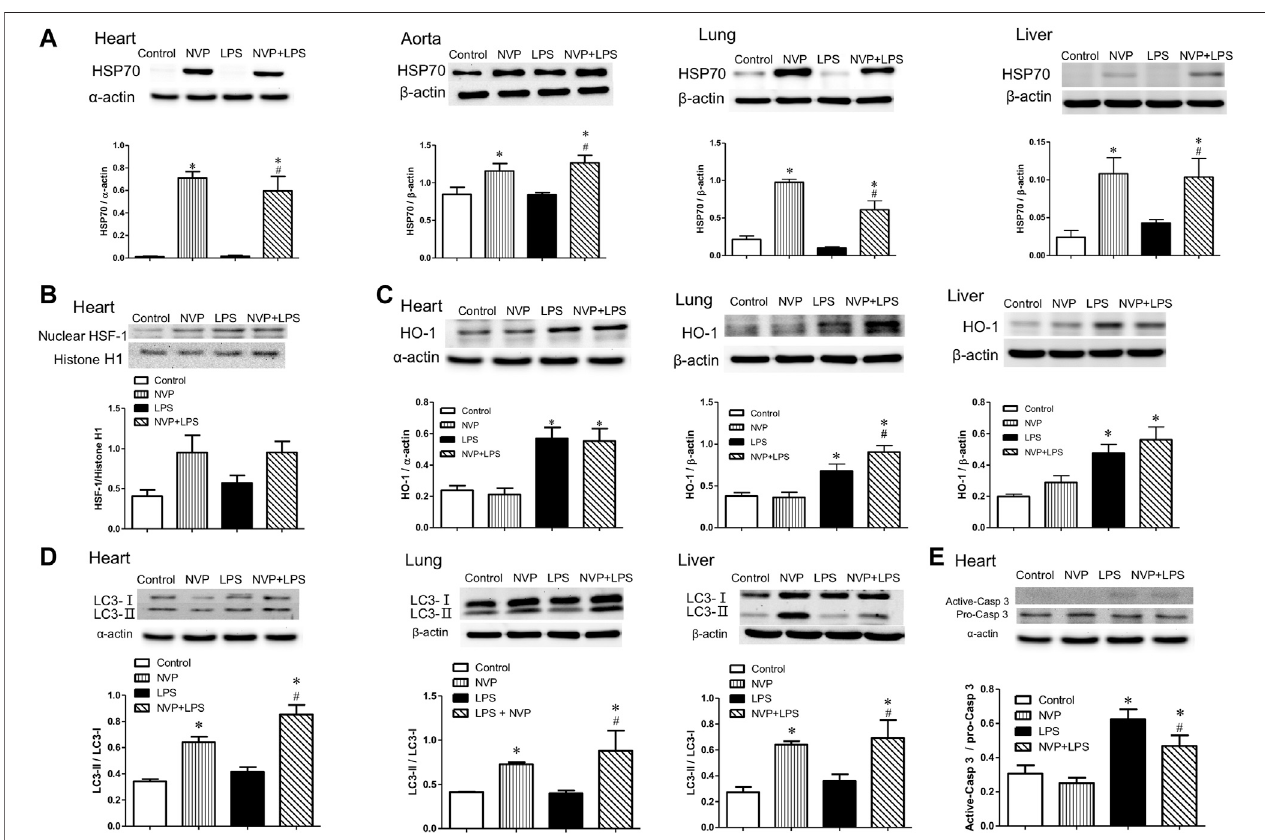
FIGURE 5 | Effects of NVP-AUY922 on anti-in fl ammatory protein expressions. (A) Effects of NVP-AUY922 pre-treatment on HSP70 in hearts, aortas, lungs and livers 6 h after LPS administration in rats. (B) Effects of NVP-AUY922 pre-treatment on nuclear HSF-1 expression in hearts 6 h after LPS administration in rats. (C) LPS effectsonautophagyinmultipleorgans.EffectsofNVP-AUY922pre-treatmentonHO-1inhearts,lungs,andlivers6 hafterLPSadministrationinrats. (D) LPSeffectson apoptosis in multiple organs. Effects of NVP-AUY922 pre-treatment on LC3 protein expression in hearts, lungs, and livers 6 h after LPS administration in rats. (E) Effects of NVP-AUY922 pre-treatment on the ratio of active form caspase 3 and pro-form caspase 3 protein expression of hearts 6 h after LPS administration in rats. NVP: NVP-AUY922 5 mg/kg. HSF-1: heat shock factor-1. HO-1: heme oxygenase-1. Values are expressed as mean ± SEM. * p < 0.05 vs. Control group, # p < 0.05 vs. LPS